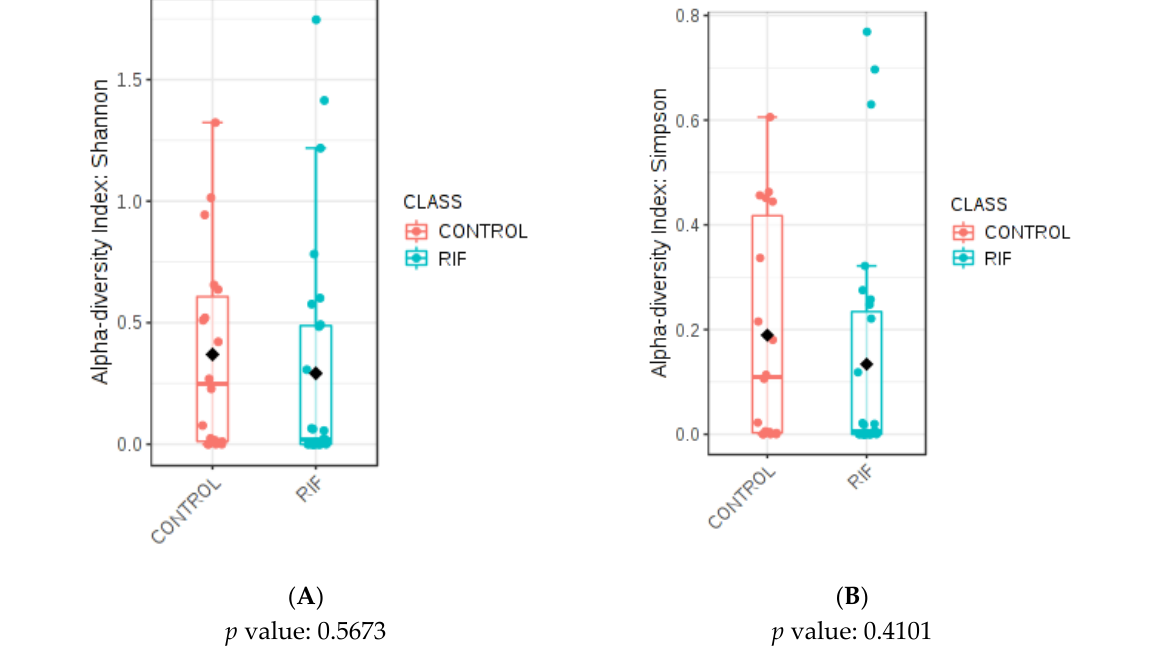
Figure 1. Alpha diversity analysis in the study population. ( A ) Comparative analysis of the Shannon diversity index ( p = 0.567) and ( B ) the Simpson diversity index ( p = 0.410) for the RIF and control groups. MicrobiomeAnalyst MDP. Black blocks indicate the midpoint of the alpha-diversity indexes.